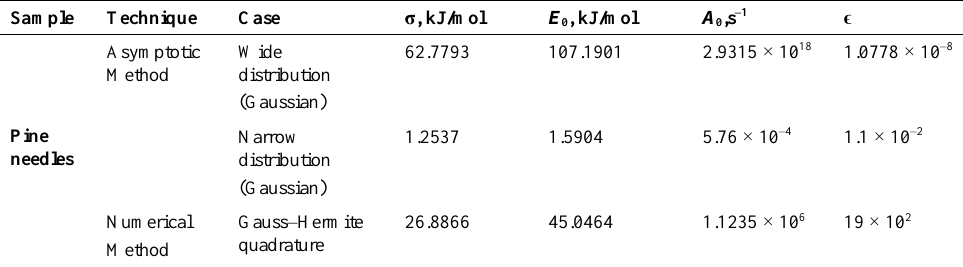
Fig. 3. Pyrolysis decomposition of pine needles at 283 K/min (a) integral; (b) differential (experimental, DAEM (Narrow and Wide distribution cases). T ABLE 2. K INETIC P ARAMETERS O BTAINED BY DAEM AND E RROR IN V ARIOUS M ETHODS FOR P INE N EEDLES D